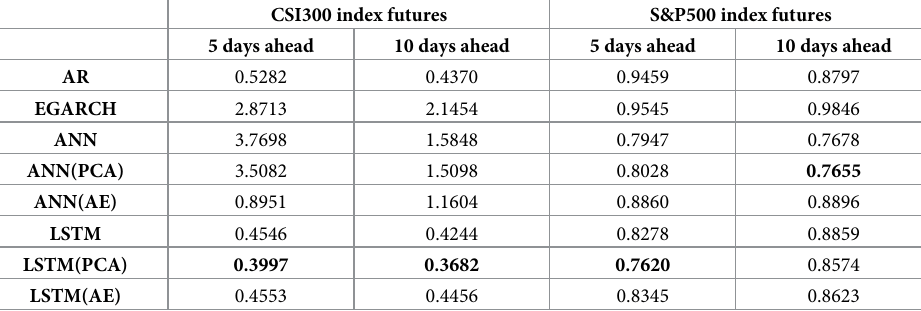
Table 5. Prediction performances in terms of NMSE on testing